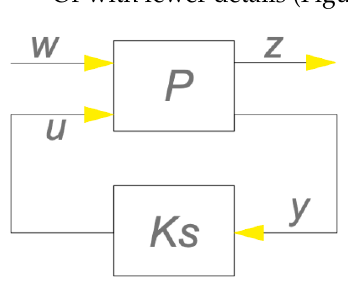
Figure 3. Two-port detailed graph.